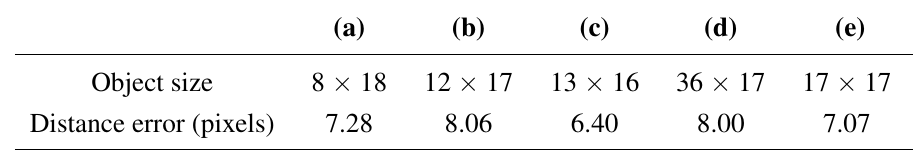
Table 1. The accuracy of object detection from Figure 12.